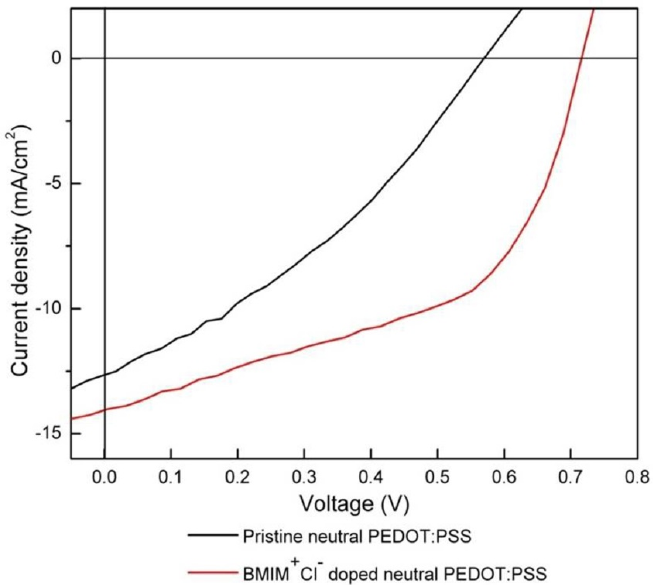
Figure 8. Current density–voltage (J–V) characteristics of PTB7:PCBM solar cells used with liquid EGaIn cathode and with pristine and BMIM + Cl − -doped neutral PEDOT:PSS as the hole-transport layer. Table 2. Photovoltaic parameters of PTB7:PCBM solar cells with BMIM + Cl − -doped acidic PEDOT:PSS as hole-transport layers used with liquid EGaIn electrode.